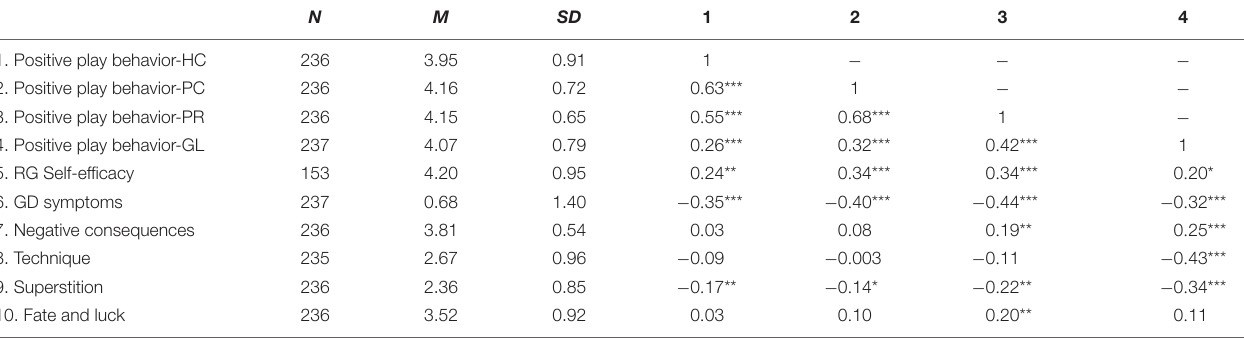
TABLE 3 | Bivariate correlations of PPS-AC constructs and other key variables.